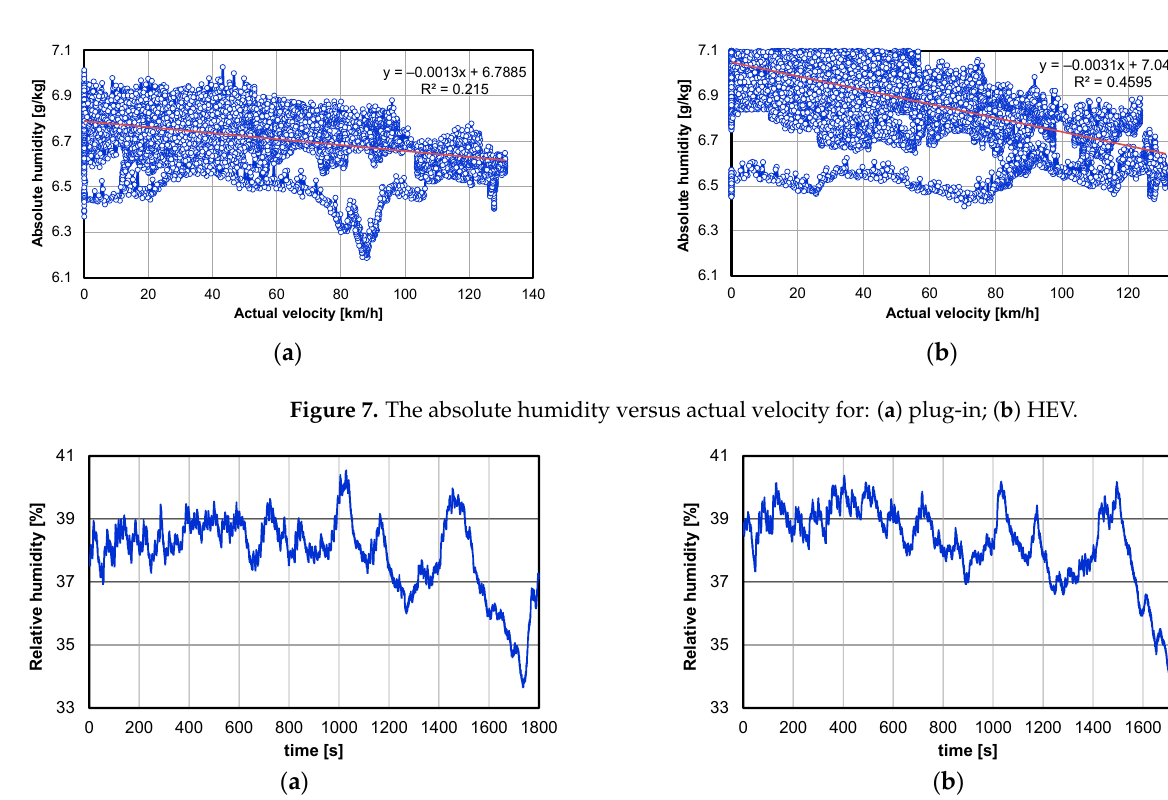
Figure 6. The absolute humidity versus time for: ( a ) plug-in; ( b ) HEV.